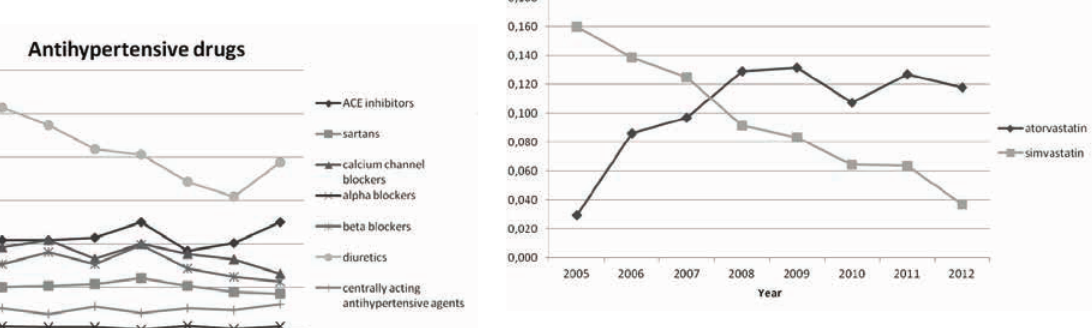
Figure 4: An increase in atorvastatin use (at the 5% significance level) and a decrease in simvastatin use (at the 1% significance level) occurred in the treatment of